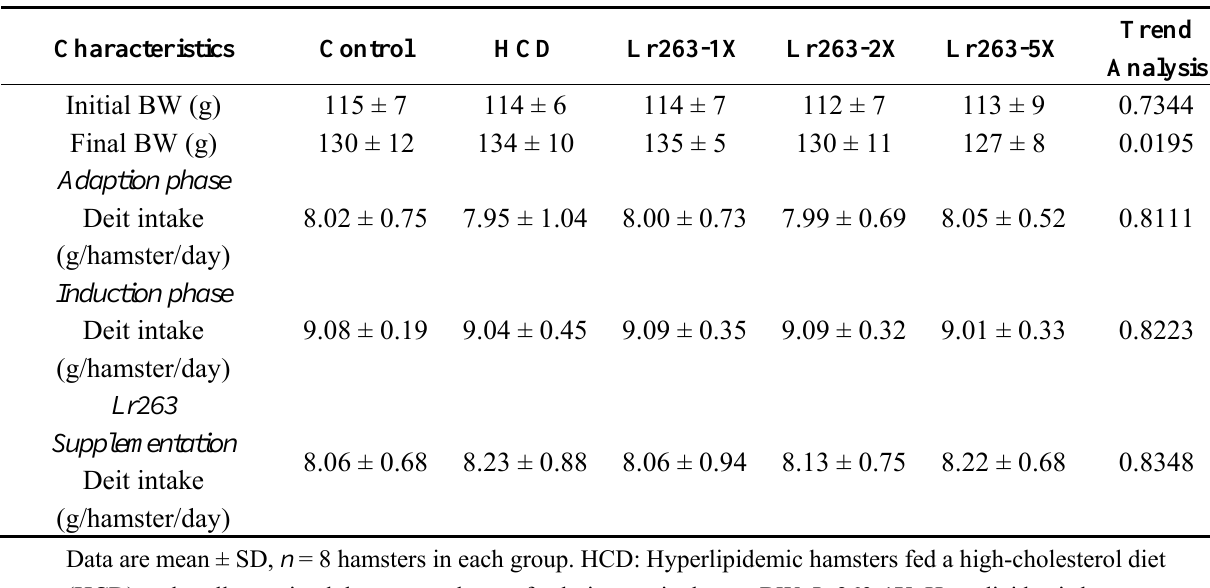
Table 1. Body weight (BW) and daily food intake for the experimental